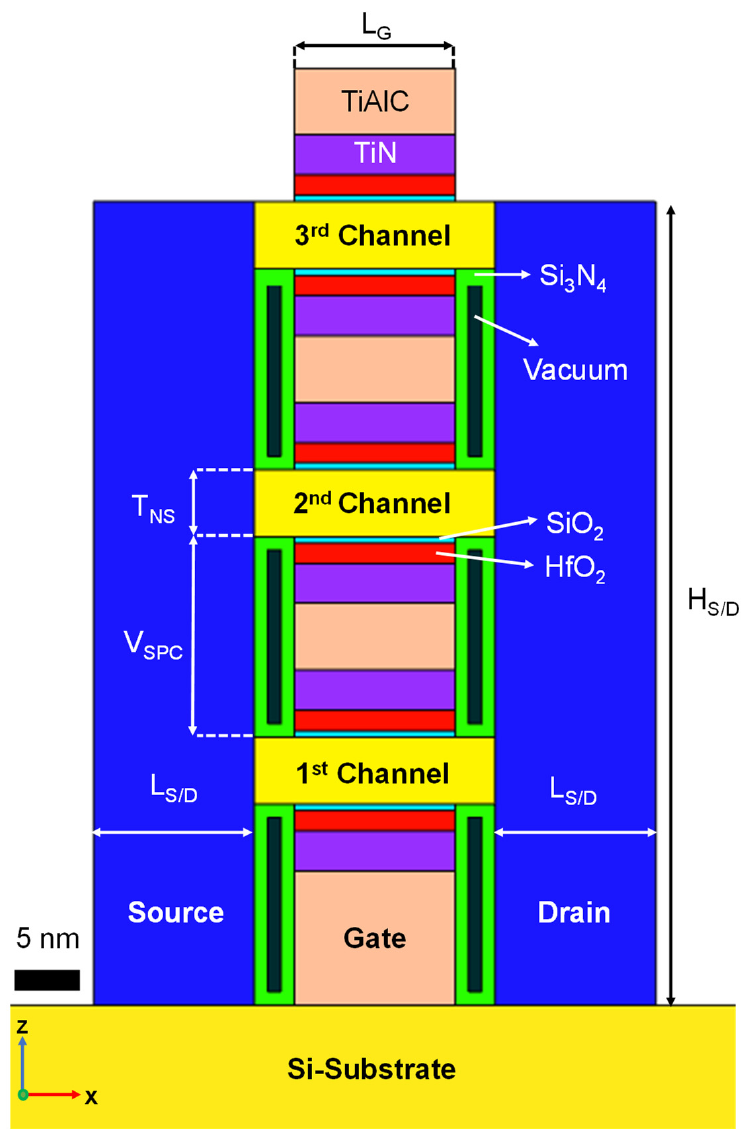
Figure 1. Cross-sectional schematic of an NS FET with vacuum inner spacer for ETA simulations.